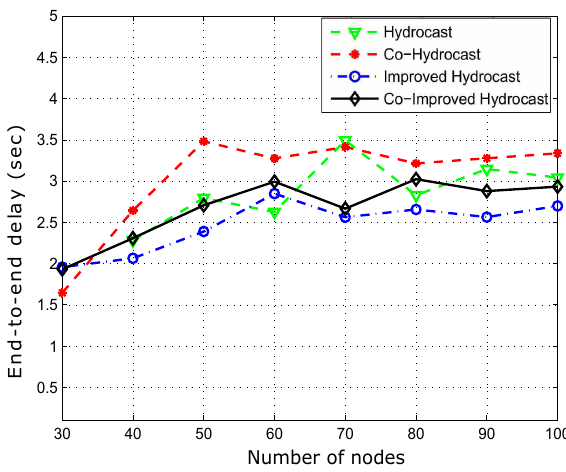
Figure 15. Average propagation delay between source and